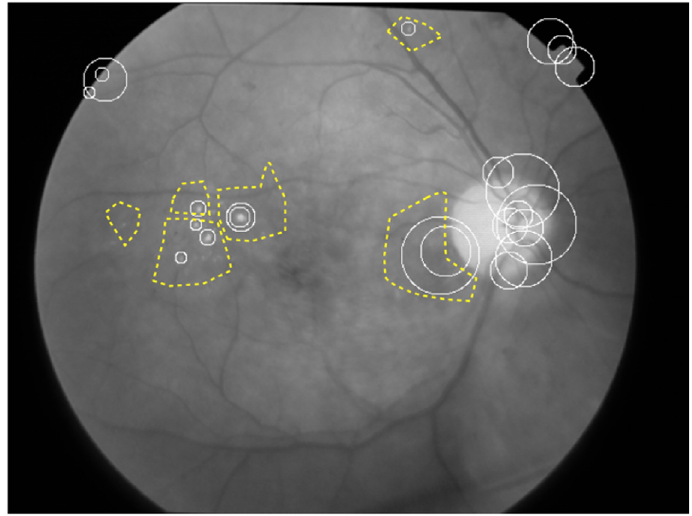
Fig 1. Retinal image. Regions of Interest (dashed line boundaries) and PoI (solid, circular boundaries).